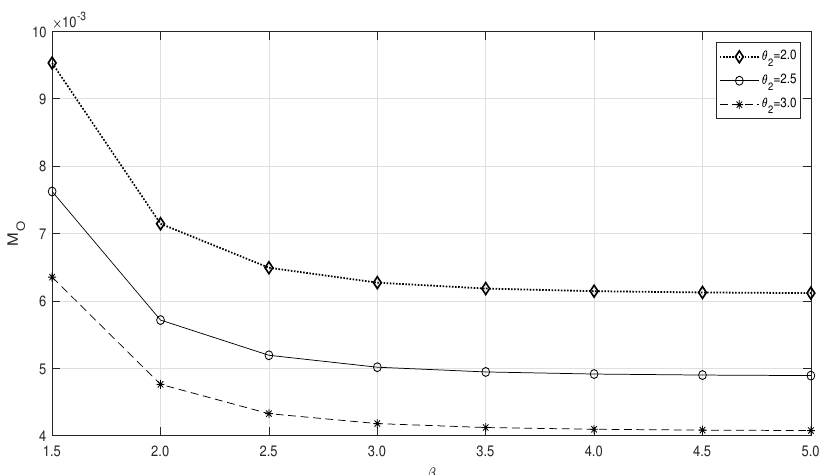
Figure 4. Mean number of customers in the orbit on θ 2 vs. β .